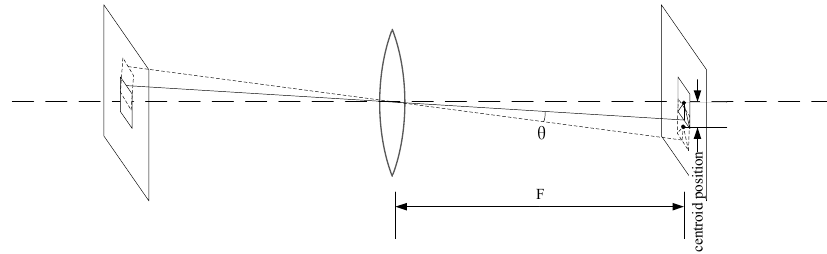
Figure 6. Schematic diagram of angular offset conversion of optical structure.